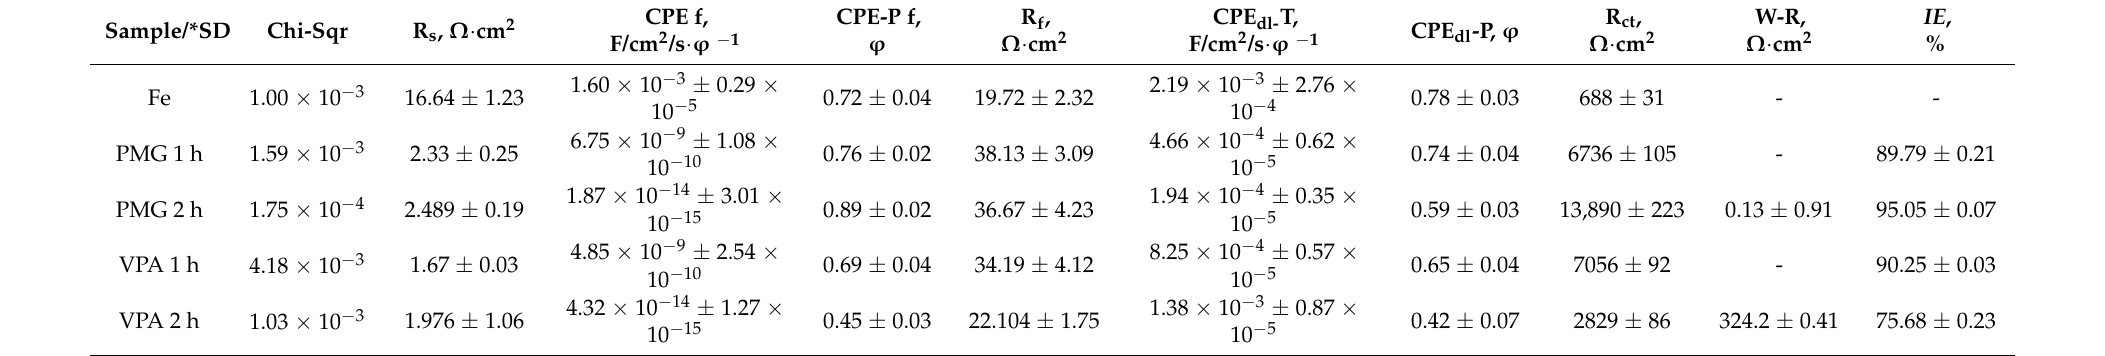
Table 2. Values of the electric circuit elements for the electrodes after 1 and 2 h of